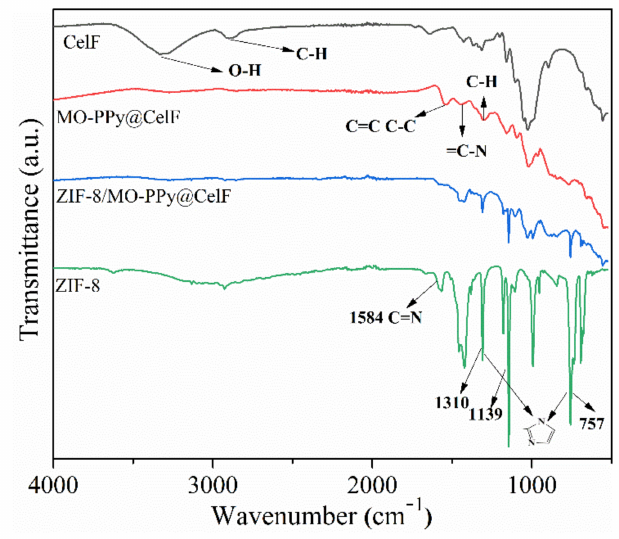
Figure 5. FTIR spectra of CelF, MO-PPy@CelF, ZIF-8 and